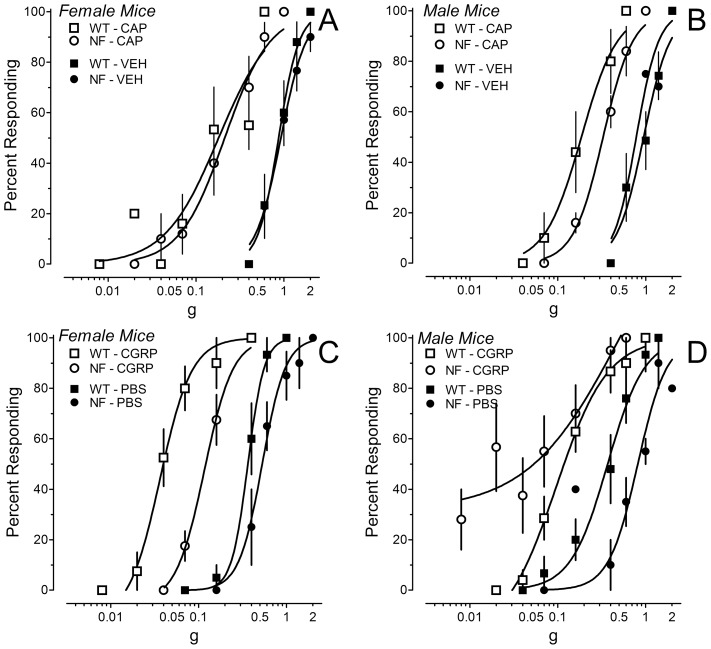
Mechanical hypersensitivity induced by intraplantar injection of 0.001% capsaicin (CAP) or 5 µg CGRP.(A, B) Force-response curves for the ipsilateral hindpaw after injection of CAP or vehicle (VEH) in Nf1+/− (circles) or WT (squares) mice. Data are the mean ± SEM of responses by 5–7 mice of each gender and genotype. (C, D) Force-response curves for the ipsilateral hindpaw after injection of CGRP or PBS in Nf1+/− (circles) or WT (squares) mice. Data in panels C-D are the mean ± SEM of responses by 4–8 mice of each gender and genotype, with the exception of CGRP in Nf1+/− mice where 11 mice were tested.